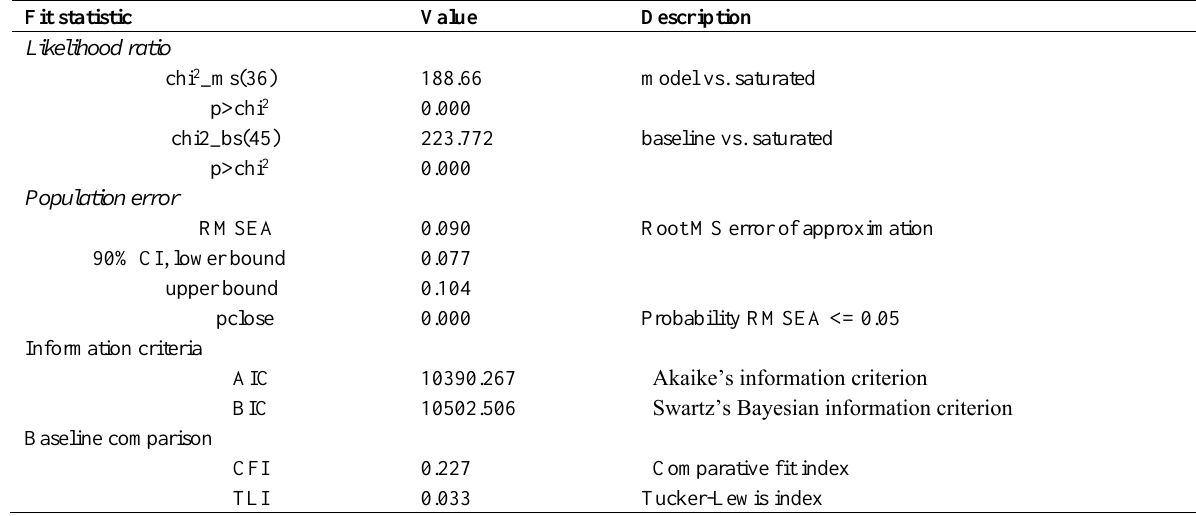
Table 5: Fit-test